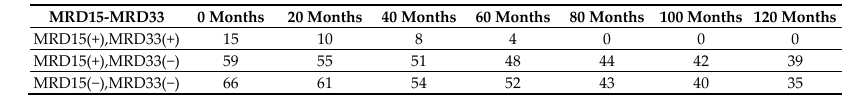
Figure 4. Outcomes of patients (n-140), 5y OS, by response to MRD (negative, <0.01% vs. positive, ≥ 0.01%) on days 15 (TP1) and 33 (TP2).